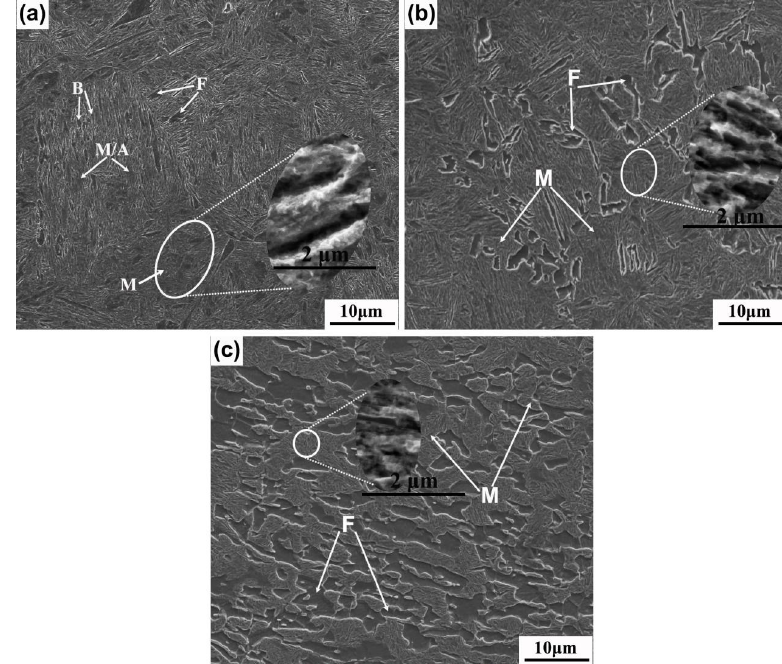
Figure 3. SEM microstructures of different specimens: (a) without deformation; (b) 25% strain; (c) 50% strain